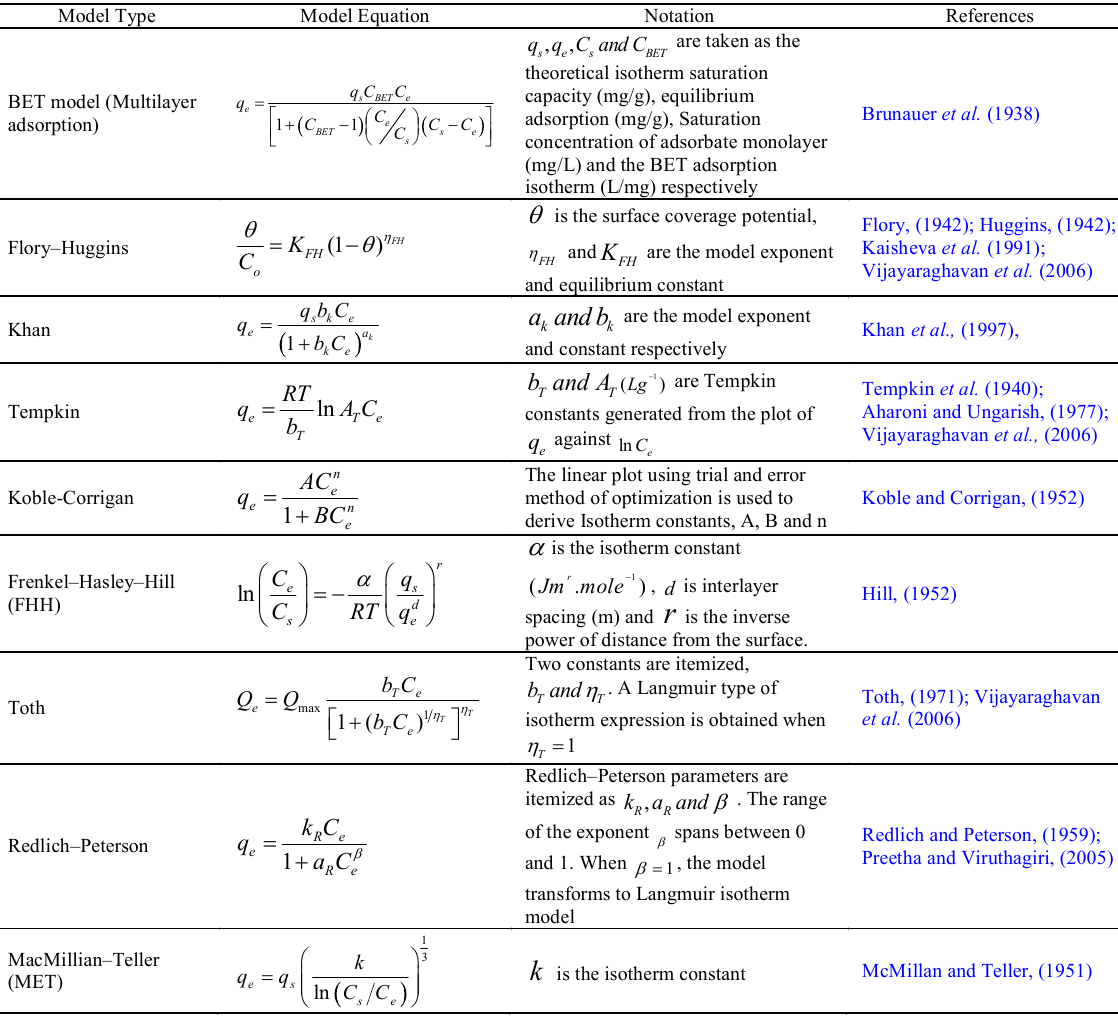
Table 4: Different Biosorption models used in